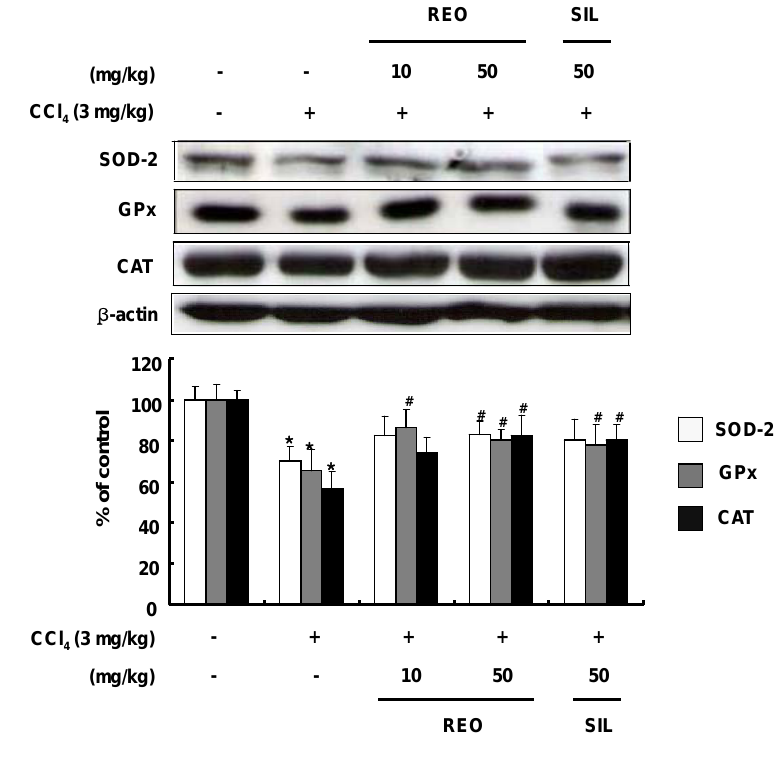
Figure 7. Effects of REO on SOD, GPx and CAT protein expression in CCl Each value represents the mean ± SD for 8 mice. * p < 0.05, significant differences from